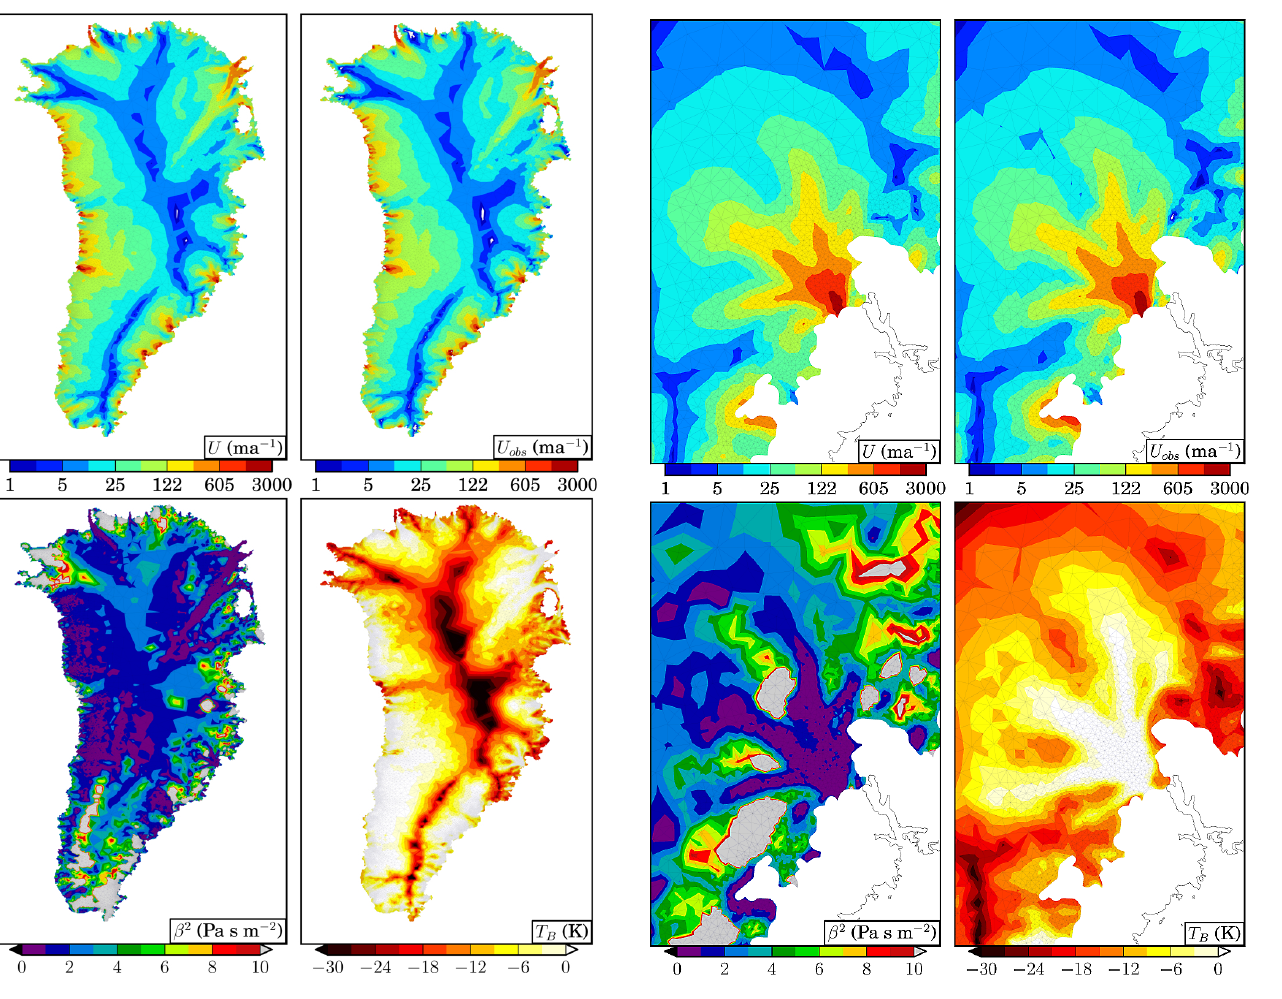
Fig. 13. Modelled and measured surface velocities, basal traction, and basal temperature of Kangerdlugssuaq glacier in eastern Green- land after assimilation of surface